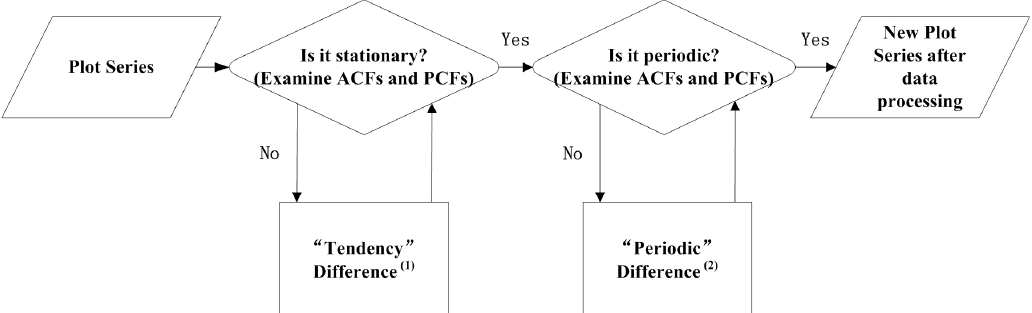
Figure 3. Workflow of data preprocessing: (1) This process is used to eliminate interference from the tendency of plot series and to finally achieve a stationary series, which usually works after the first difference. If not, the difference calculation continues (second difference, third difference, etc.) until the plot series is stationary; (2) This process is used to eliminate the interference from periodicity of the plot series, which should be carried out after the “tendency” difference, to remove the effect of such a “tendency.” The aim is to achieve an independent series over time. It usually works after calculating the first difference with 1-cycle lags (e.g., circadian series: lags = 24 h).